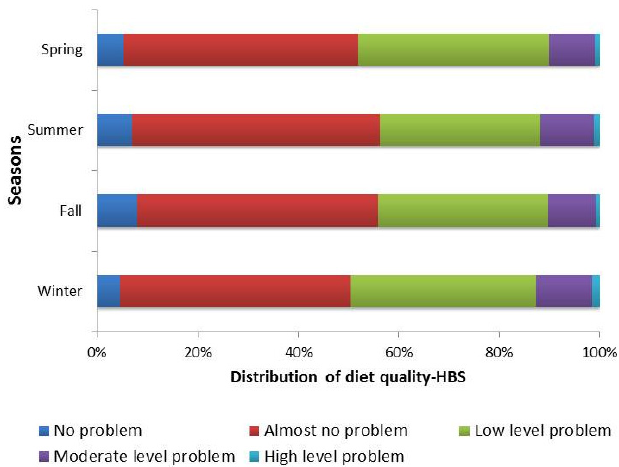
Figure 1. Distribution of the higher bound score (HBS) (Score range of HBS is 0–32; No problem: 0; Almost no problem: 1–6; Low level: 7–13; Moderate level: 14–19; High level: >19.